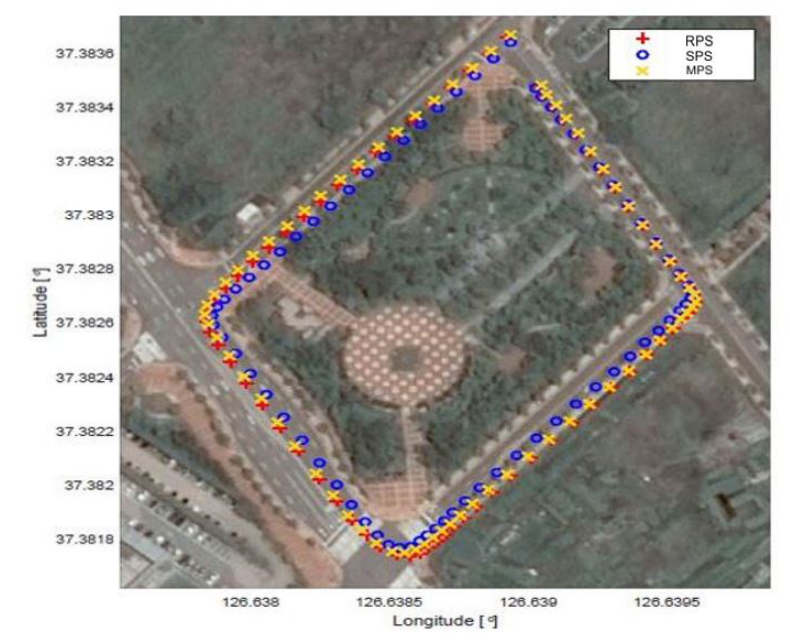
Figure 1. Trajectories of a